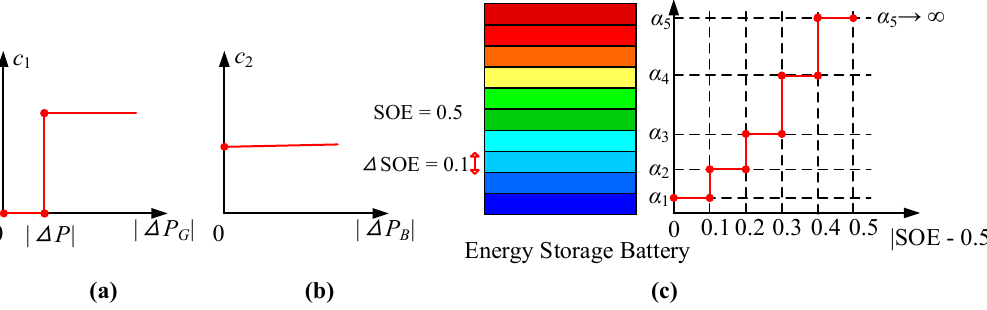
Figure 3. Cost functions of ( a ) grid-connected power fluctuations ∆ P G ( t ) , ( b ) energy storage output P B , and ( c ) energy storage charge and discharge depth.